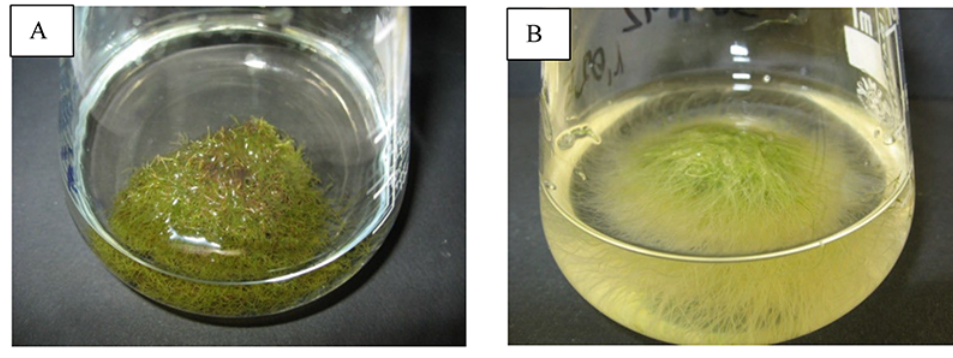
Figure 17 Scutellaria barbata root cultures cultivated in IBA-supplemented ( A ) B5 and ( B ) SH medium.